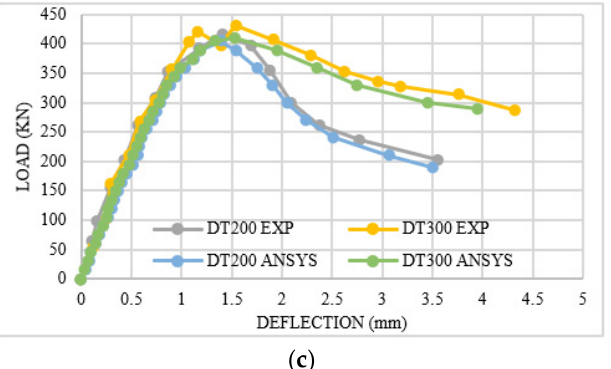
Figure 7. Comparison between (P- ∆ ) resulting from the FEA by authors and the experimental tests by Lanhui Guo et al. for specimens with D / t ranging from 75 to 300. ( a ) Specimens of D / t 75 and 100. ( b ) Specimens of D / t 125 and 150. ( c ) Specimens of D / t 200 and 300.